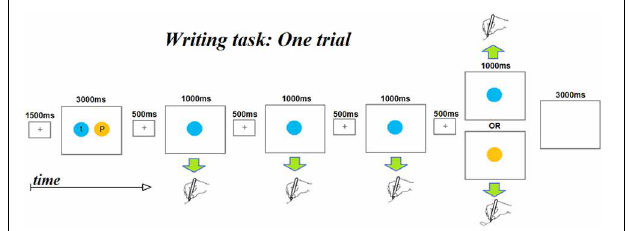
FIGURE 1 | A schematic depicting the time course of the events that makes up a single fMRI scanner trial. Each trial begins with a presentation of two colored circles, each containing a letter. Participants had been instructed to encode the color-letter mappings as the colors were to serve as prompts for the letters to be written subsequently within the trial. Note that each trial involves writing four letters. The first three letters are always the same letter, while the fourth may be the same letter (No-change trials) or a different letter (Change trials). Color and letter pairings change from trial to